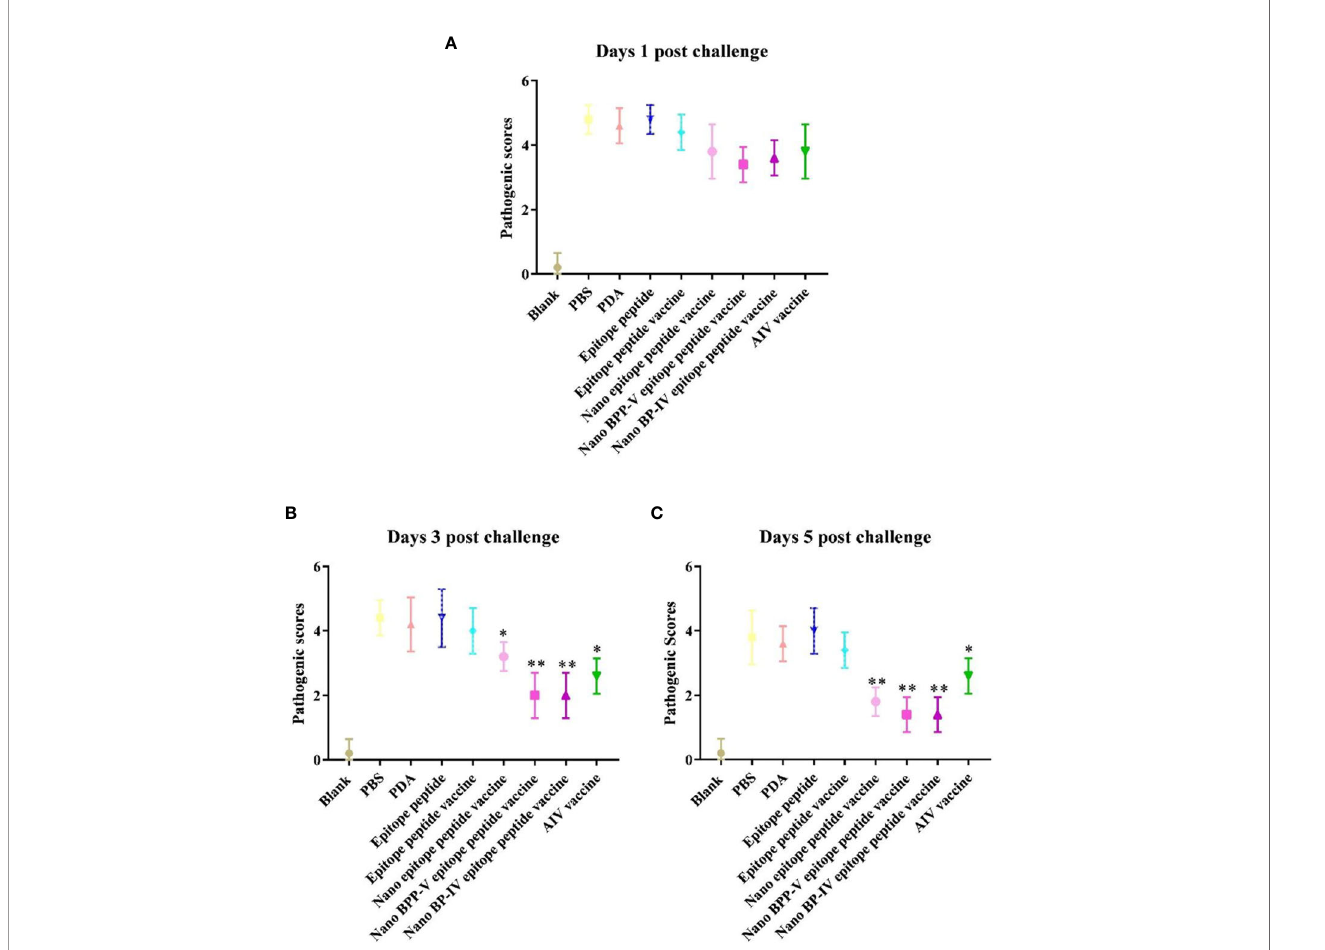
FIGURE 10 | Pathological scores of processed lung sections on days 1, 3 and 5 after the challenge. The lungs of mice were collected from each group (n = 5) and sectioned to evaluate the pathological scores. The scoring standard was as follows: 0, no pathology; 1, local pulmonary congestion and in fl ammatory cell in fi ltration; 2, pulmonary congestion and in fl ammatory cell in fi ltration affecting 10% of the section; 3, pulmonary congestion and in fl ammatory cell in fi ltration affecting 20% of the section; 4, pulmonary congestion and in fl ammatory cell in fi ltration affecting 20-50% of the section; and 5, pulmonary congestion and in fl ammatory cell in fi ltration affecting > 50% of the section. * P < 0.05 and ** P < 0.01, compared with the epitope peptide vaccine group. (A) Pathological scores of lung sections on day 1 after the challenge. (B) Pathological scores of lung sections on day 3 after the challenge. (C) Pathological scores of lung sections on day 5 after the challenge. Data represent the mean ± SD (n =